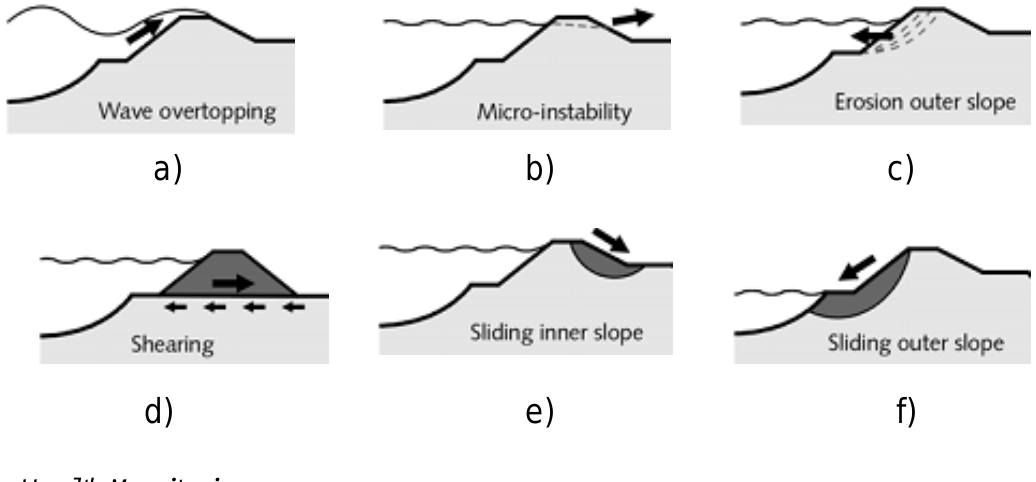
Figure 1. Classification of dam failures [10]: ( a ) wave overtopping; ( b ) micro-instability; ( c ) erosion of the outer slope; ( d ) horizontal shear; ( e ) sliding of the inner slope; ( f ) sliding of the outer